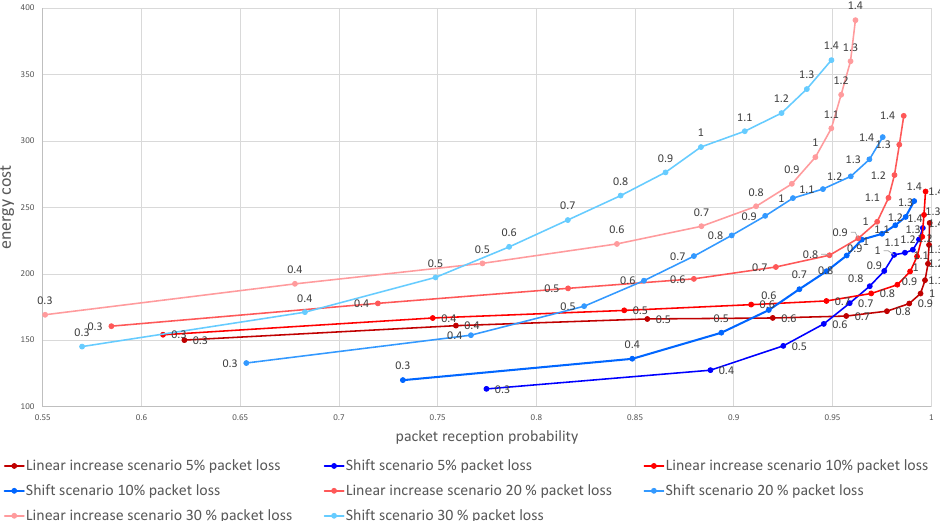
Figure 6. Dependence of the energy cost on the probability of packet delivery. Numbers above data points denote α